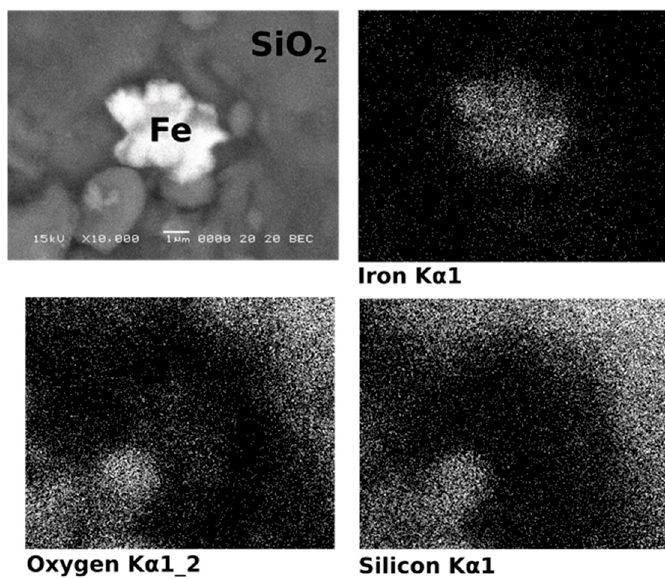
Figure 5. Iron particle on a larger quartz particle.